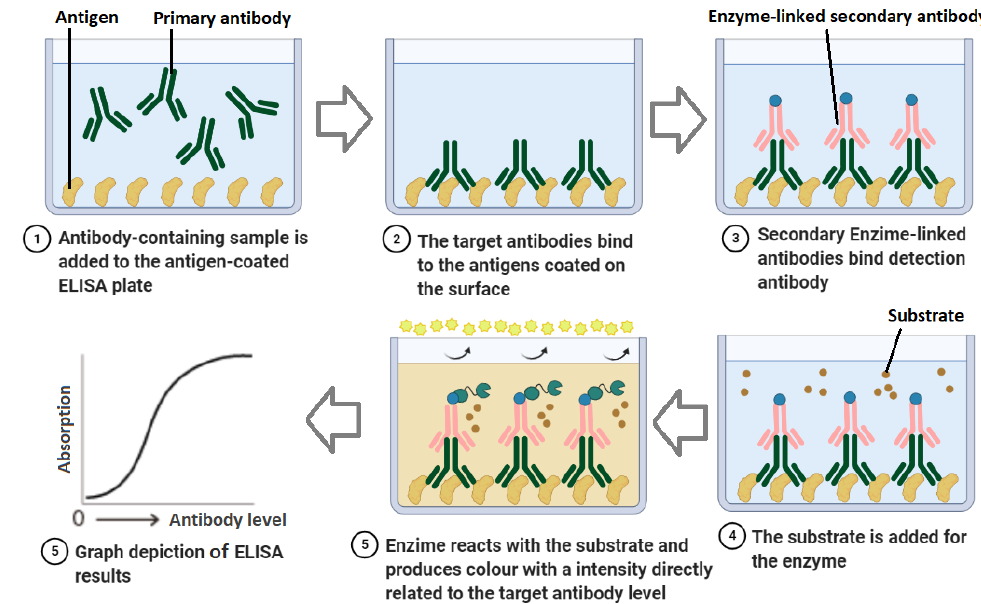
Figure 1. Schematic of ELISA technique for indirect detection of SARS-CoV-2. SARS-CoV-2 specific antibodies are added to the well and adhere to the immobilized viral antigens. Primary antibodies attach to the target antibodies, and a secondary enzyme-linked tracer antibody reacting with a chromogen is added and produces colour change. The intensity of the colour correlated with the concentration of the antigen in the sample.